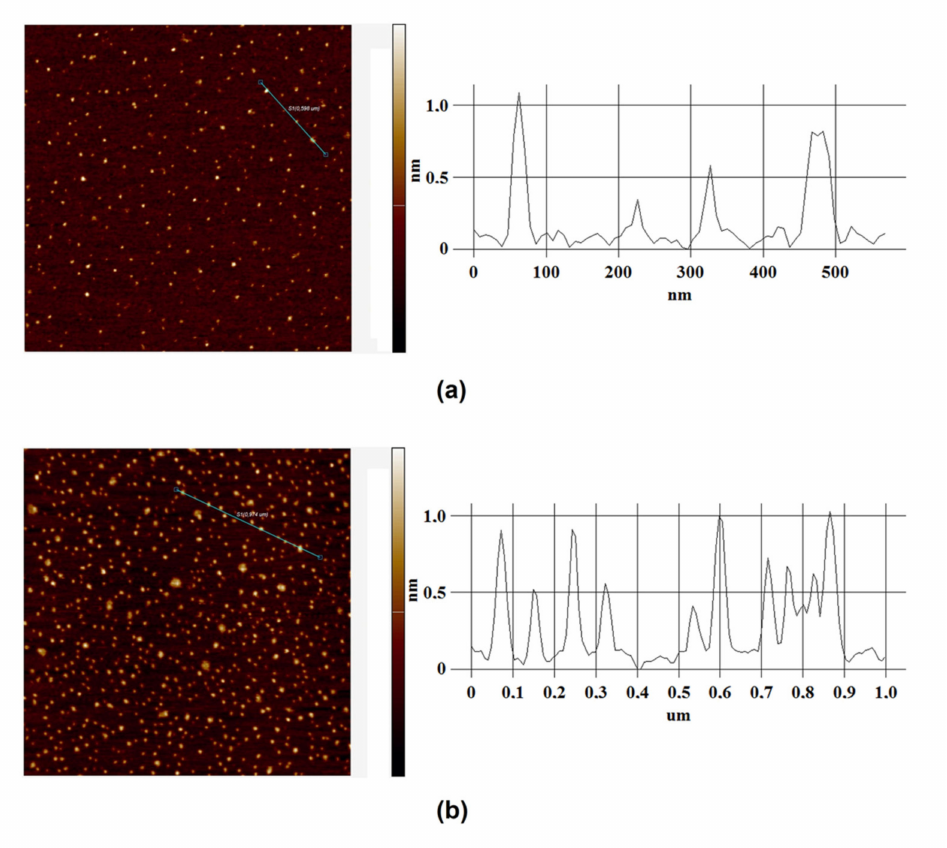
Figure 2. Results of AFM analysis for HRP solutions: typical AFM images of the mica surface with adsorbed HRP particles (left) and corresponding cross section profiles indicated by the blue lines in the AFM images (right). The measuring cell (containing HRP solution) was placed either far away at a 10 m distance from the polymeric pipe coil (control experiment) ( a ) or within the experimental setup over the coil ( b ). The scan size of each AFM image is 2 µ m × 2 µ m, and the Z scale is 1.1 nm ( a ) and 1.2 nm ( b